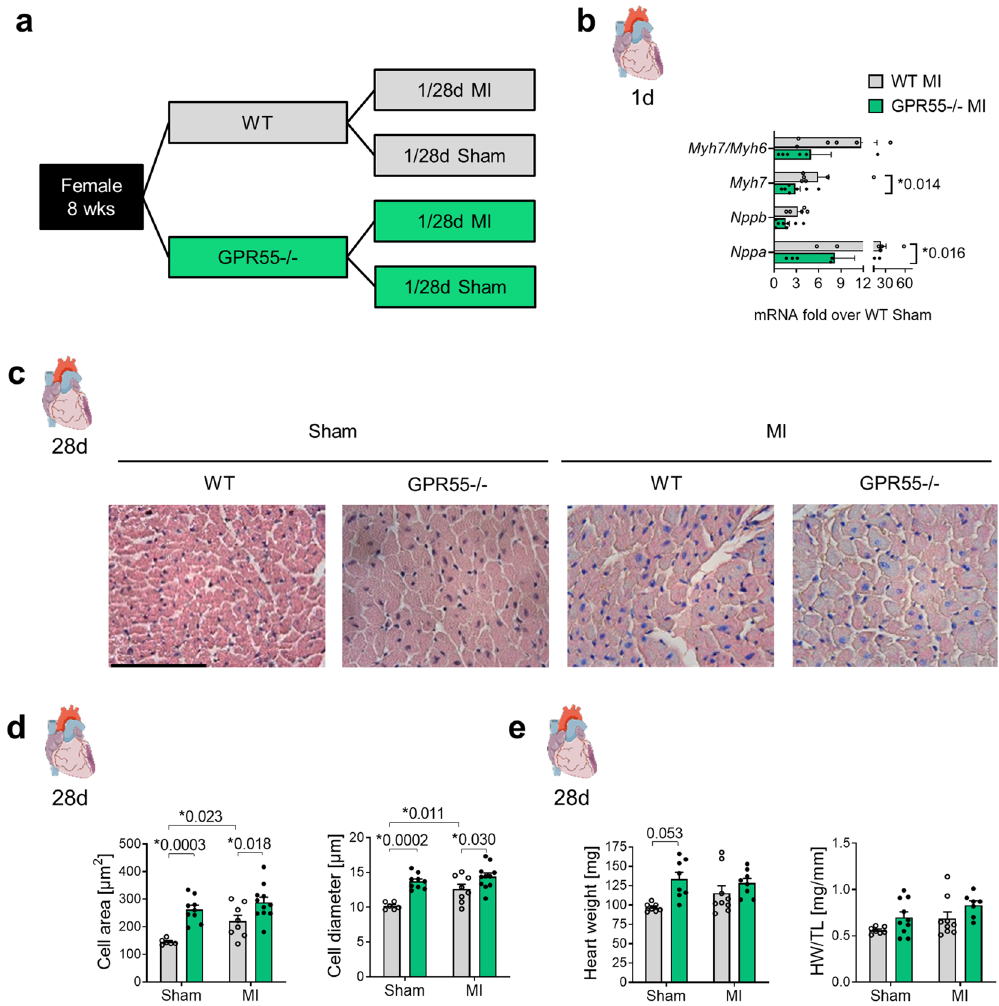
Figure 6. Impact of GPR55 deficiency on LV hypertrophy following MI. ( a ) Study design to assess the role of GPR55 in early hypertrophy and long-term remodelling. GPR55−/− and WT mice were randomly assigned to MI or sham surgery for 1 day or 28 days. ( b ) LV expression of foetal genes and Myh7 expression relative to the adult MHC isoform Myh6 in WT and GPR55−/− mice 1 day post-MI, as fold over Sham WT. ( c ) Representative haematoxylin & eosin stained midventricular cross-sections from WT and GPR55−/− mice 28 days post-MI or sham surgery, respectively (× 40 magnification, scale bar 100 µm) and ( d ) quantification of cardiomyocyte cross sectional area and diameter. ( e ) Heart weight (HW) per se and normalized against tibia length (TL) in WT and GPR55−/− mice 28 days post-MI or sham surgery, respectively. Bars indicate mean ± SE (n = 6–11/group) (Two- way ANOVA with Sidak’s post hoc test).